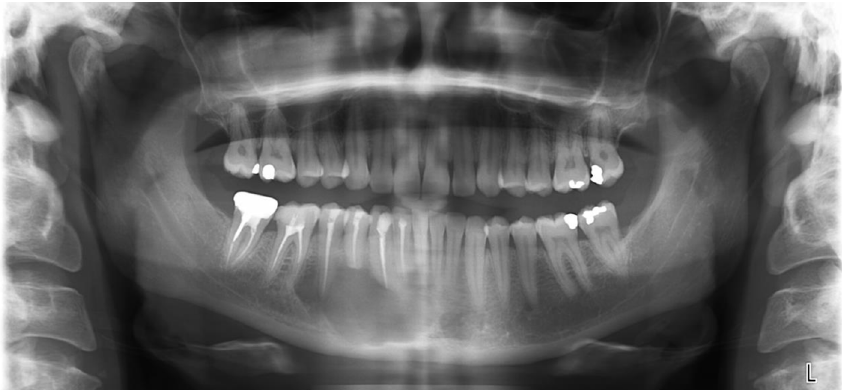
Fig. 1. Orthopantomogram. Osteolytic lesion of the horizontal branch of the mandible with root resorption of 43, 44,